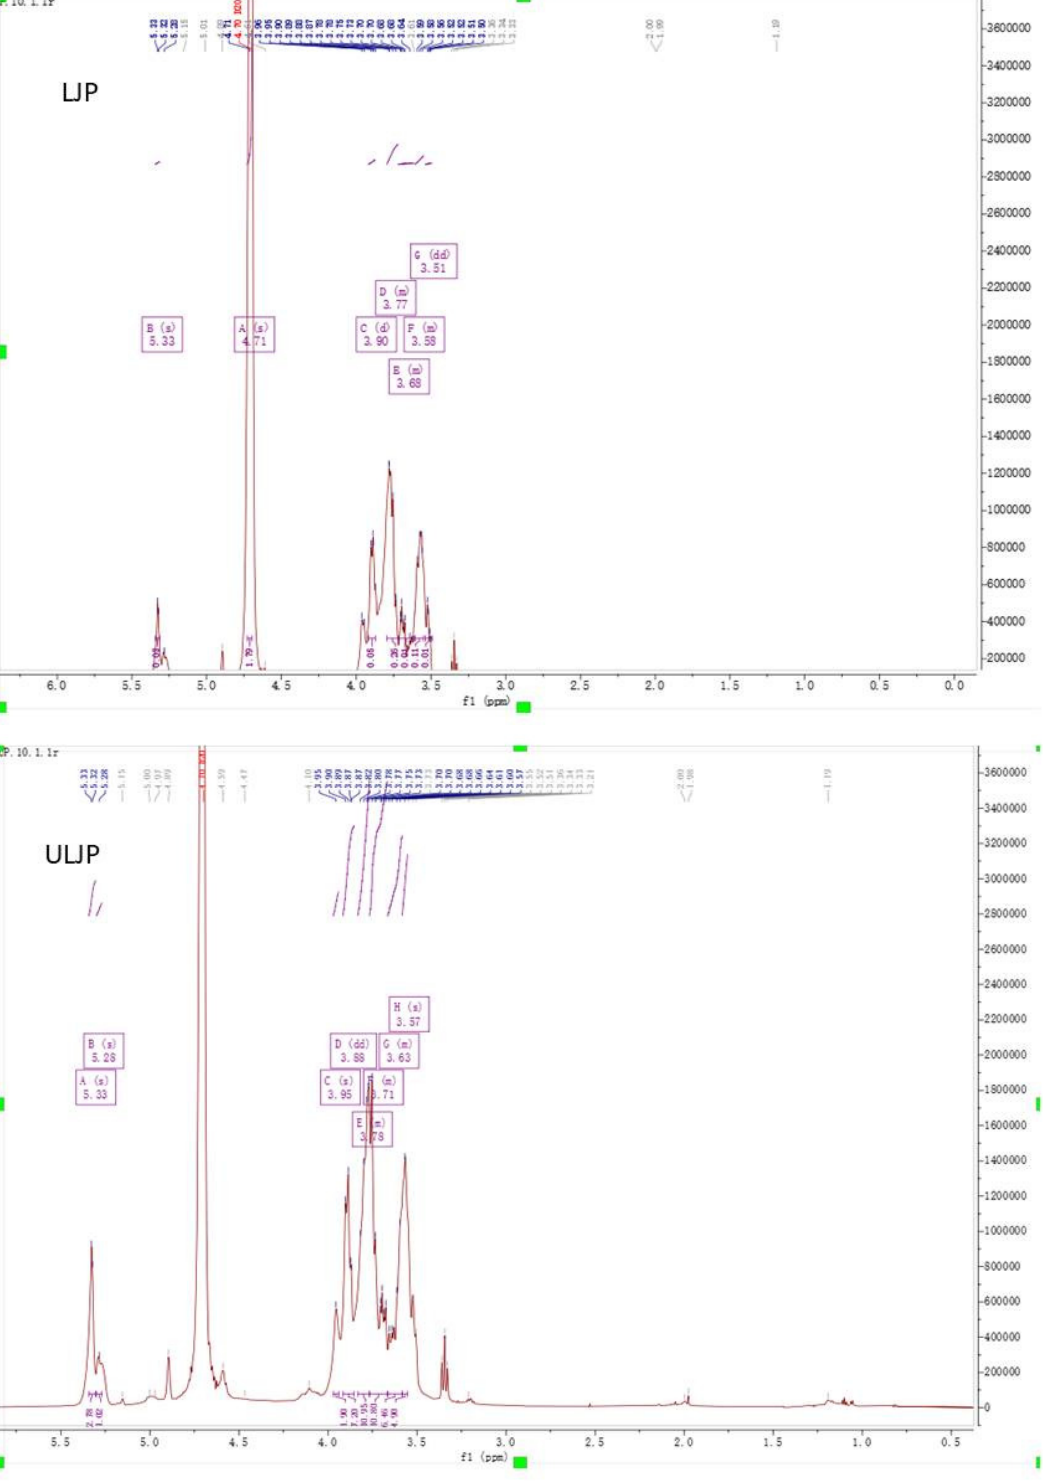
Figure 3. NMR spectra of LJP and ULJP (solvent = D 2 O): 1 H NMR spectrum.